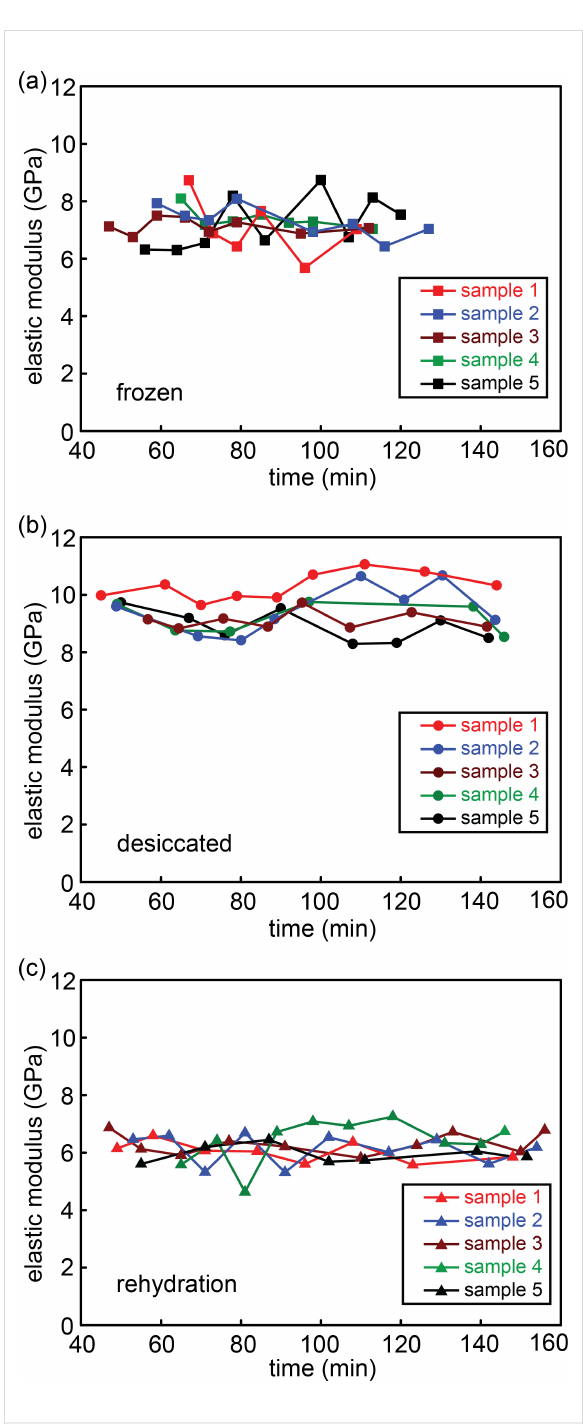
Figure 3: Elastic modulus of (a) frozen, (b) desiccated and (c) rehy- drated tibiae against recorded time. Different colors represent different